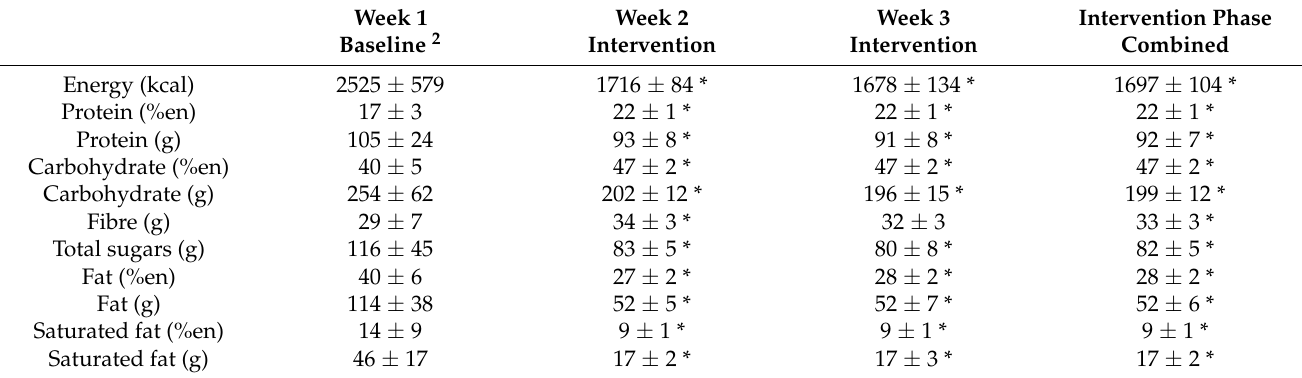
Table 3. Overview of daily intake of key nutrients before and during the dietary intervention phase 1